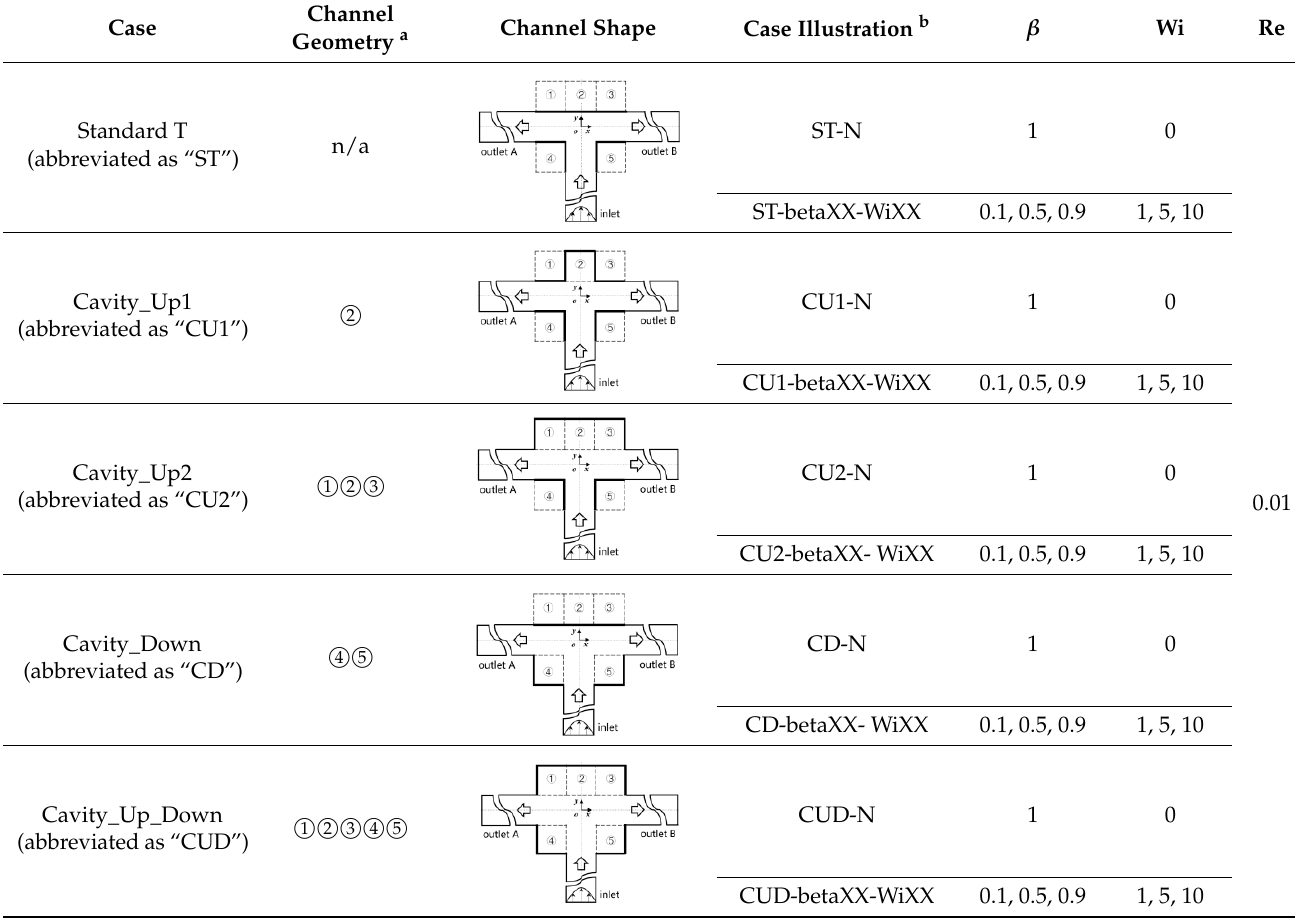
Table 3. Description of different channel structures and numerical database. Figure 1. Schematic of the microfluidic oscillator channel.